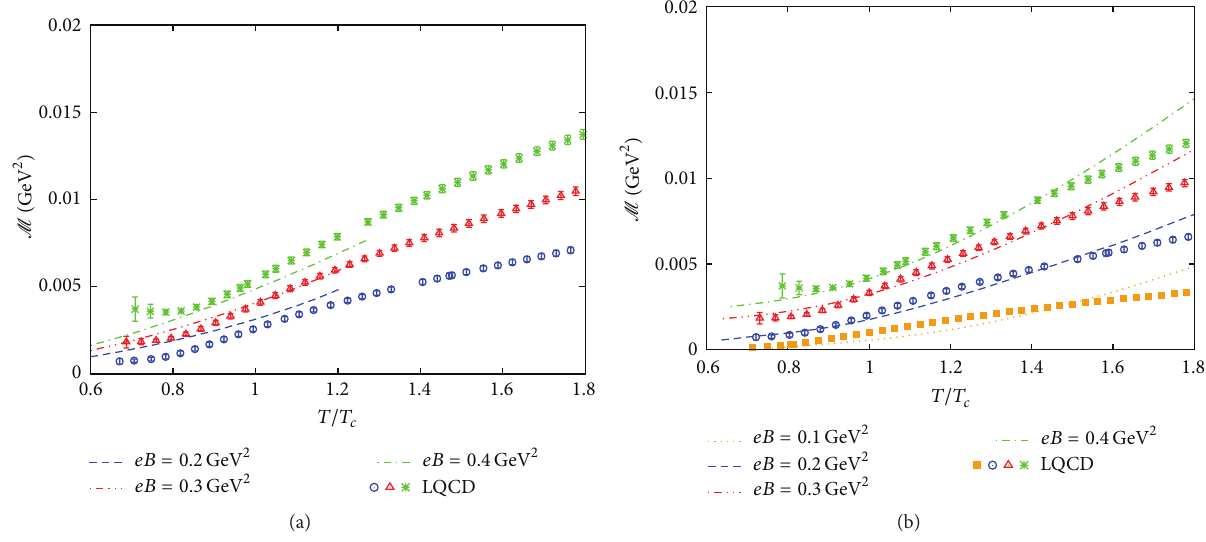
Figure 2: The magnetization M is given as a function of temperature at 𝑒𝐵 = 0.0 – 0.4 GeV 2 and compared with lattice results (symbols) [12]. The HRG results are depicted in (a), while those from PLSM are in